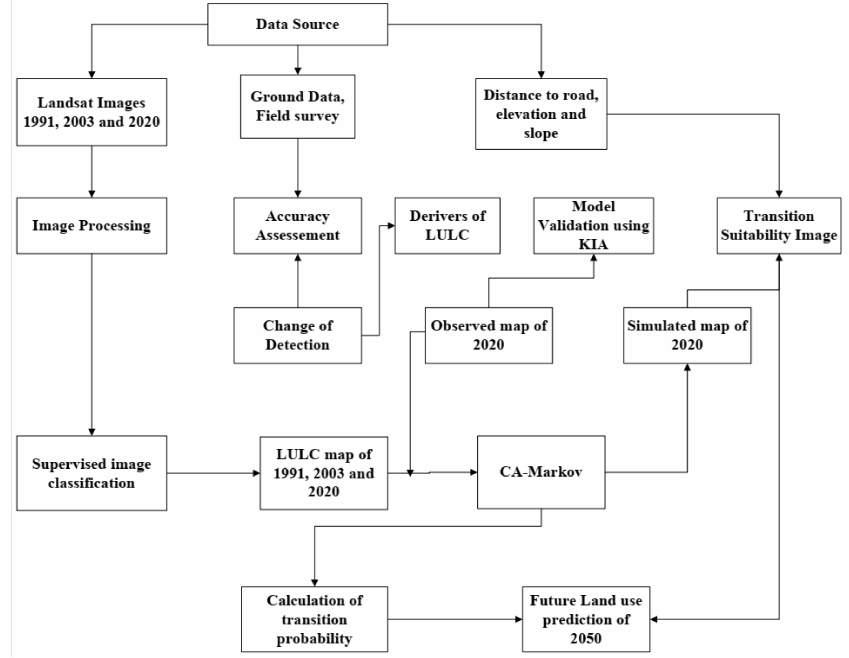
Figure 5. Methodological flow chart of LULC simulation and prediction of the